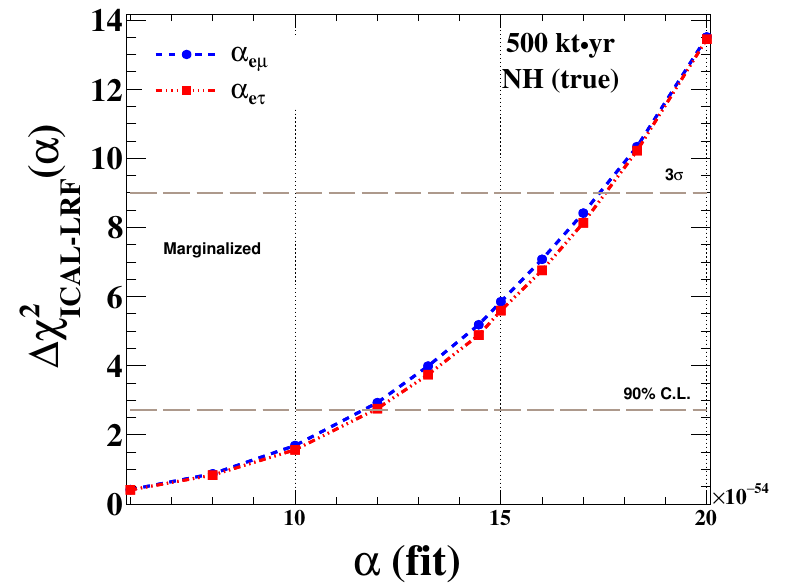
Figure 11 . ICAL’s sensitivity to (cid:11) e(cid:22) (blue dashed line) and (cid:11) e(cid:28) (red dash-dotted line) using 500 kt (cid:1) yr exposure and assuming NH as true